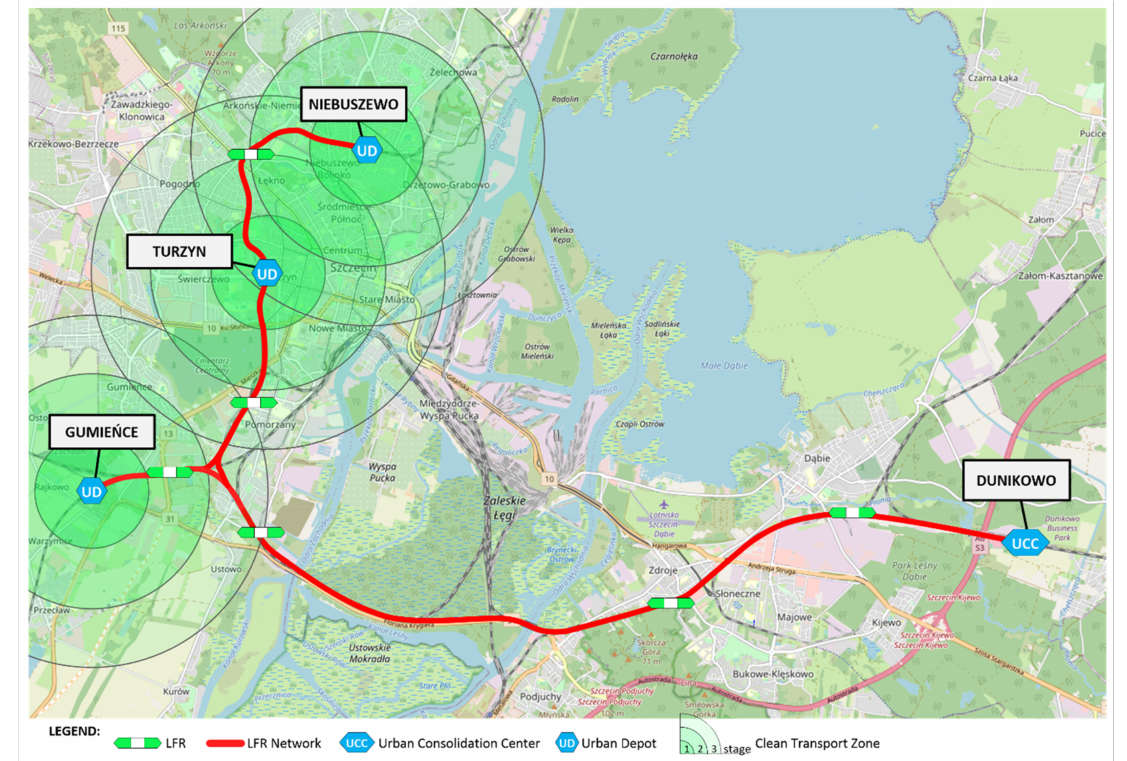
Figure 7. Spatial expansion of CTZs in Szczecin in the case of applying